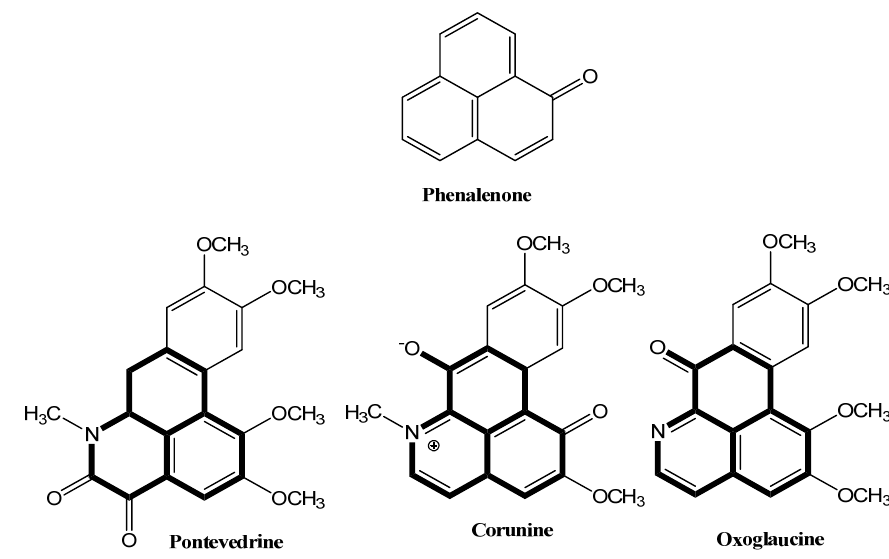
Figure 1. Chemical structures of phenalenone and